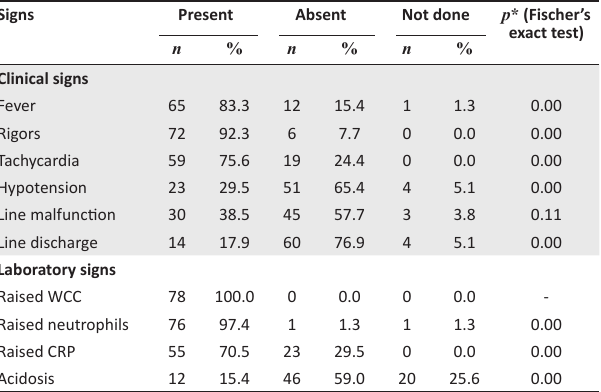
TABLE 2: Clinical and laboratory findings suggestive of sepsis.